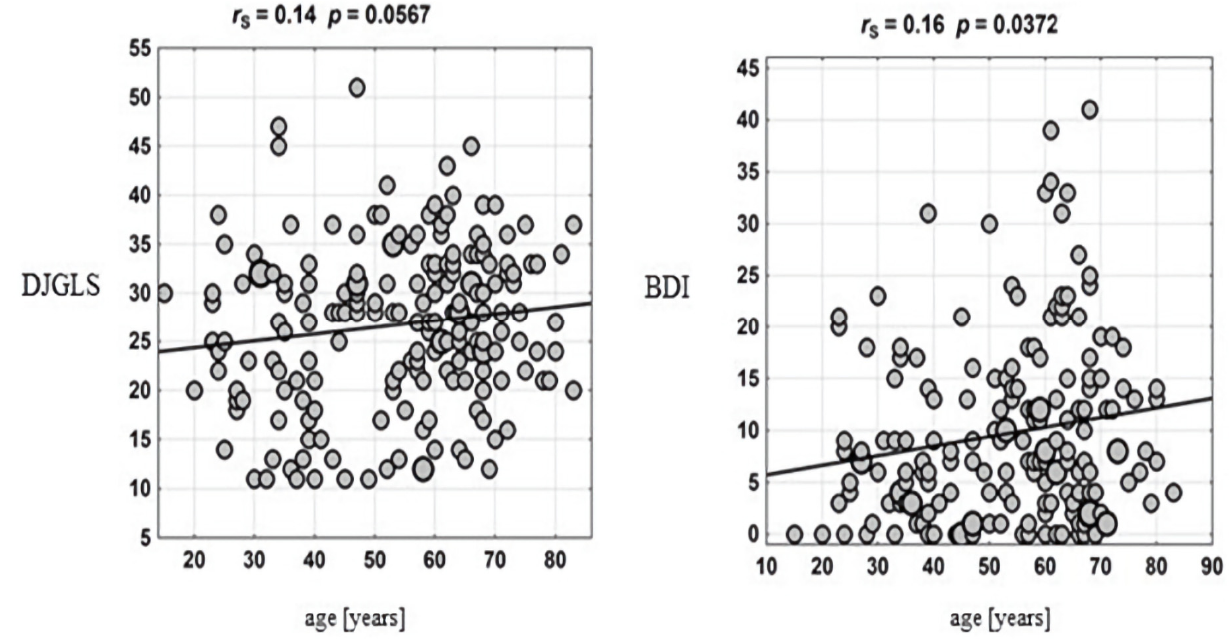
Figure 1. Correlations between the applied psychometric scales and age.